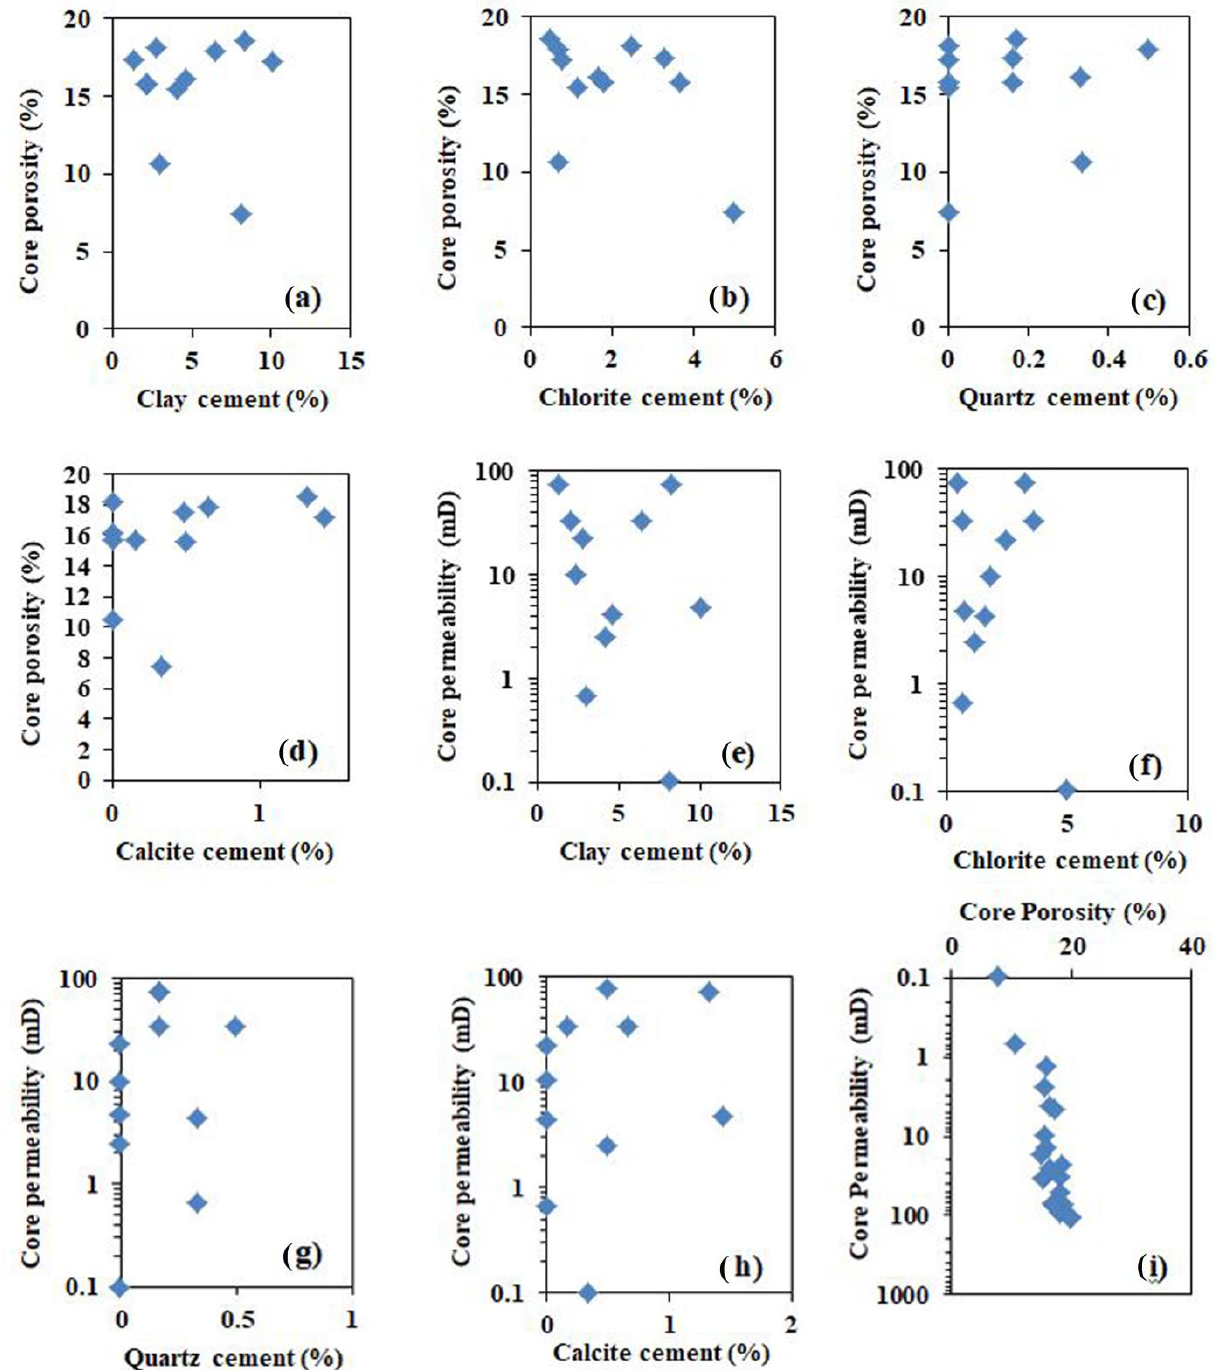
Figure 15. Relationship between ( a ) core porosity (%) vs. clay cement (%); ( b ) core porosity (%) vs. chlorite cement (%); ( c ) core porosity (%) vs. quartz cement; ( d ) core porosity (%) vs. calcite cement (%); ( e ) core permeability (mD) vs. clay cement (%); ( f ) core permeability (mD) vs. chlorite cement (%); ( g ) core permeability (mD) vs. quartz cement (%); ( h ) core permeability (mD) vs. calcite cement (%); ( i ) core permeability (mD) vs. core porosity (%).